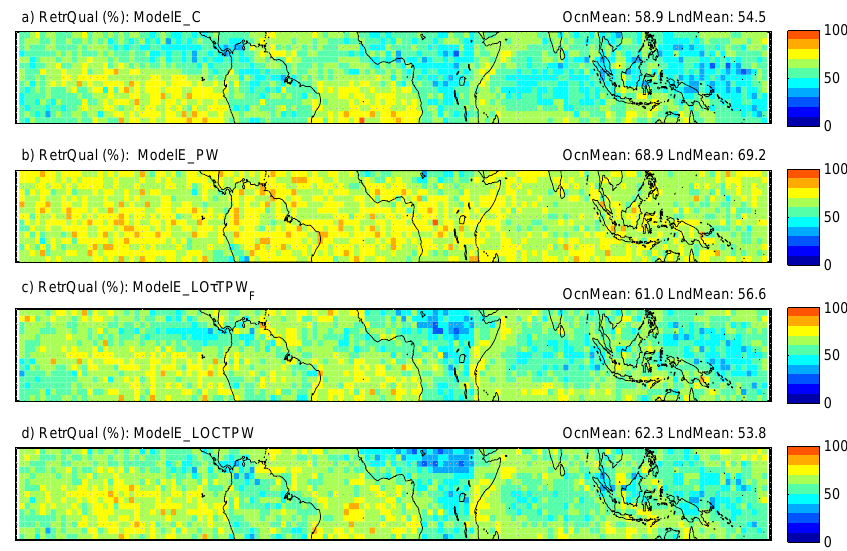
Fig. 10. Approximated retrieval quality for four representative categorizations.